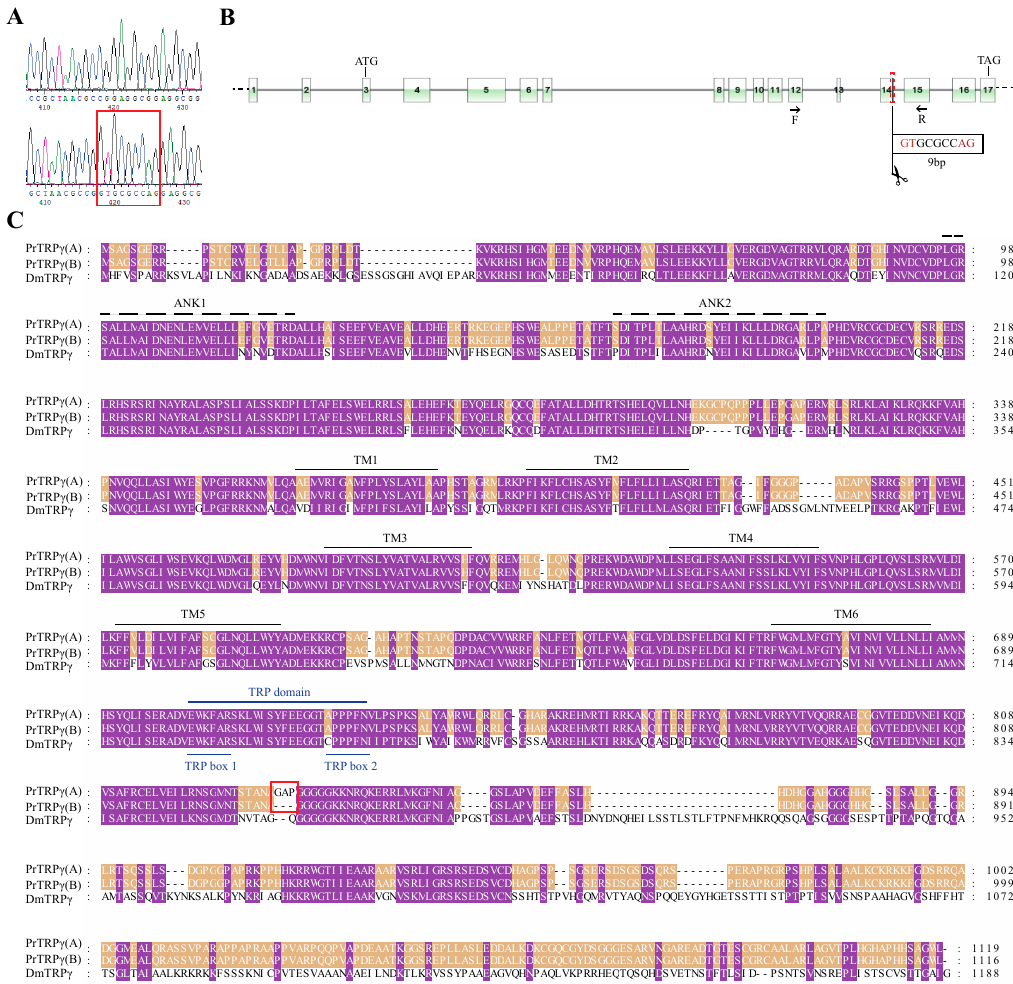
Figure 3. Detection and amino acid sequence alignment of the two PrTRP γ splice forms. ( A ) Two molecular isoforms of PrTRP γ mRNAs identified by PCR. (B) Two-dimensional gene structure map of PrTRP γ . The boxes represented the exons of PrTRP γ , the black solid lines connecting the boxes represented the introns and the black dotted lines on both sides represent other genome sequences. The deletion of 9 nucleotides at the end of exon 14 produced by splicing were showed in the black box. ( C ) Multiple sequence alignment deduced for PrTRP γ (A), PrTRP γ ( B ) and DmTRP γ . The red box indicates the different amino acid residues of the two isoforms. TRP boxes and TRP domain were indicated with blue lines. Ankyrin repeats were indicated with dotted lines and marked as ANK1–2. Transmembrane regions were indicated with solid lines and marked as TM1–6. The protein sequences used for multiple sequence alignment were in the attached fasta file.